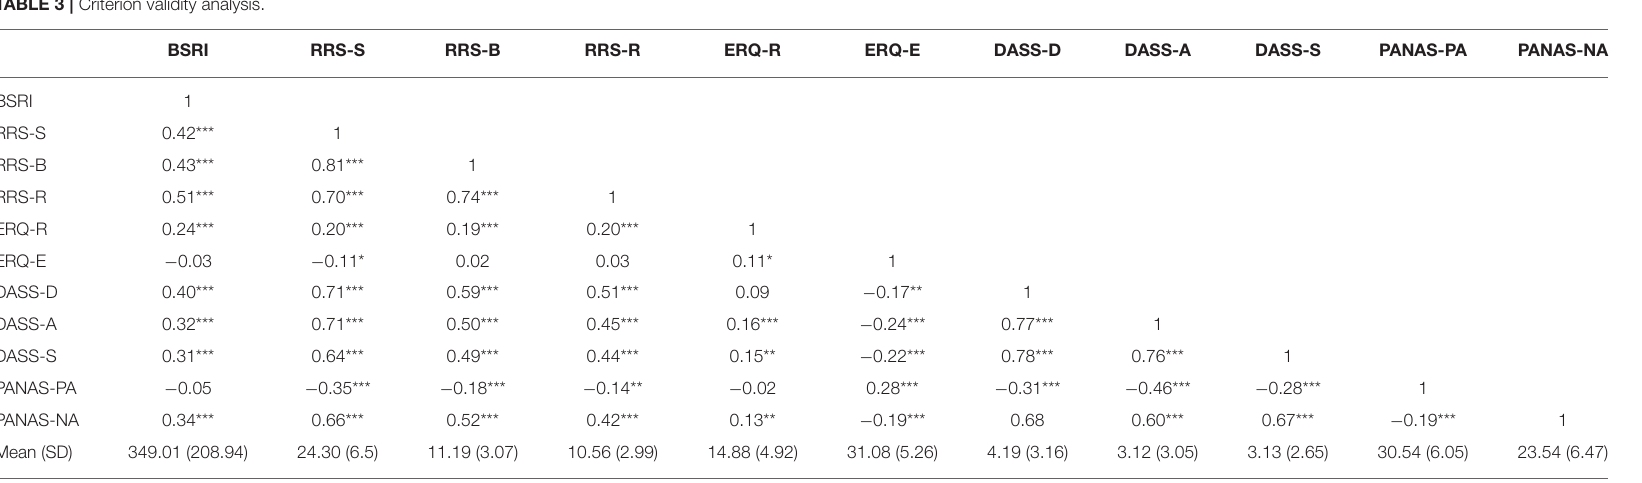
TABLE 3 | Criterion validity